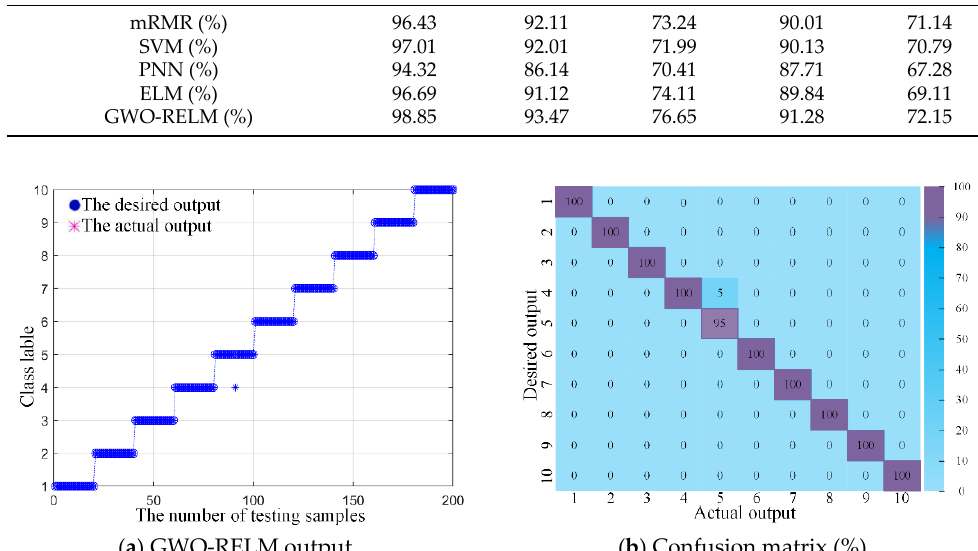
Figure 21. Identification results of the proposed method. Table 9. The performance comparison between different feature extraction models.